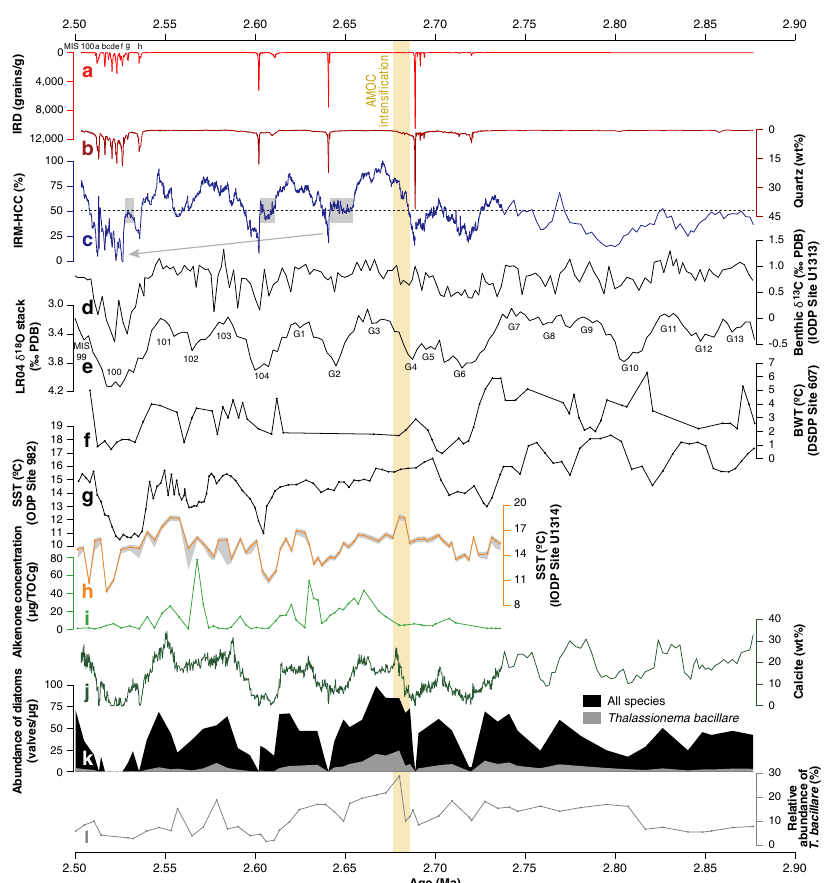
Fig. 2 Environmental changes in the subpolar North Atlantic during the intensi fi cation of Northern Hemisphere glaciation. a IRD concentration (IODP Site U1314). The record between 2.54 and 2.50 Ma 22 was re-analyzed in this study (see “ Methods ” section). Substages labeled in MIS 100 are after ref. 22 . b Quartz weight percentage (IODP Site U1314). The record between 2.54 and 2.50 Ma 22 was re-analyzed in this study (see “ Methods ” section). c HCC of IRM (IODP Site U1314). The records between 2.88 and 2.74 Ma 27 and between 2.54 and 2.50 Ma 22 were re-analyzed in this study (see “ Methods ” section). Dashed line represents an average value (0.51) calculated among the three early stages of the MIS G2, 104, and 100 glacials (gray areas). Arrow indicates a decreasing trend of the HCC in the late stages of the MIS G2, 104, and 100 glacials. d Benthic δ 13 C record reconstructed from the deep North Atlantic (IODP Site U1313) 69 . e Lisiecki and Raymo (LR04) global δ 18 O stack 16 . Marine isotope stages are labeled. f Bottom water temperature (BWT) converted from benthic foraminiferal Mg/Ca ratios (DSDP Site 607) 34 . g Alkenone ‐ based SST (ODP Site 982) 15 . h Alkenone ‐ based SST (IODP Site U1314). The shaded area along the estimated SST indicates the estimated error (0.3 °C for positive and 0.3 °C + estimated values based on the injected amount of alkenones (details are shown in the “ Methods ” section). i Alkenone concentration (IODP Site U1314). j Calcite weight percentage (IODP Site U1314). k Diatom valve concentrations of all species (black) and a warm water species, T. bacillare (gray) (IODP Site U1314). l Relative abundance of T.